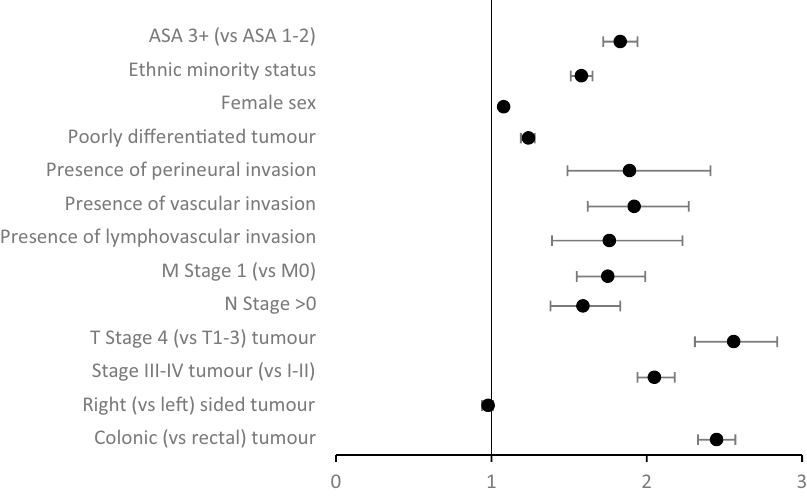
Figure 15. Summary of meta-analysis findings—association between clinicopathological characteristics and emergency presentation (odds rations and 95% confidence